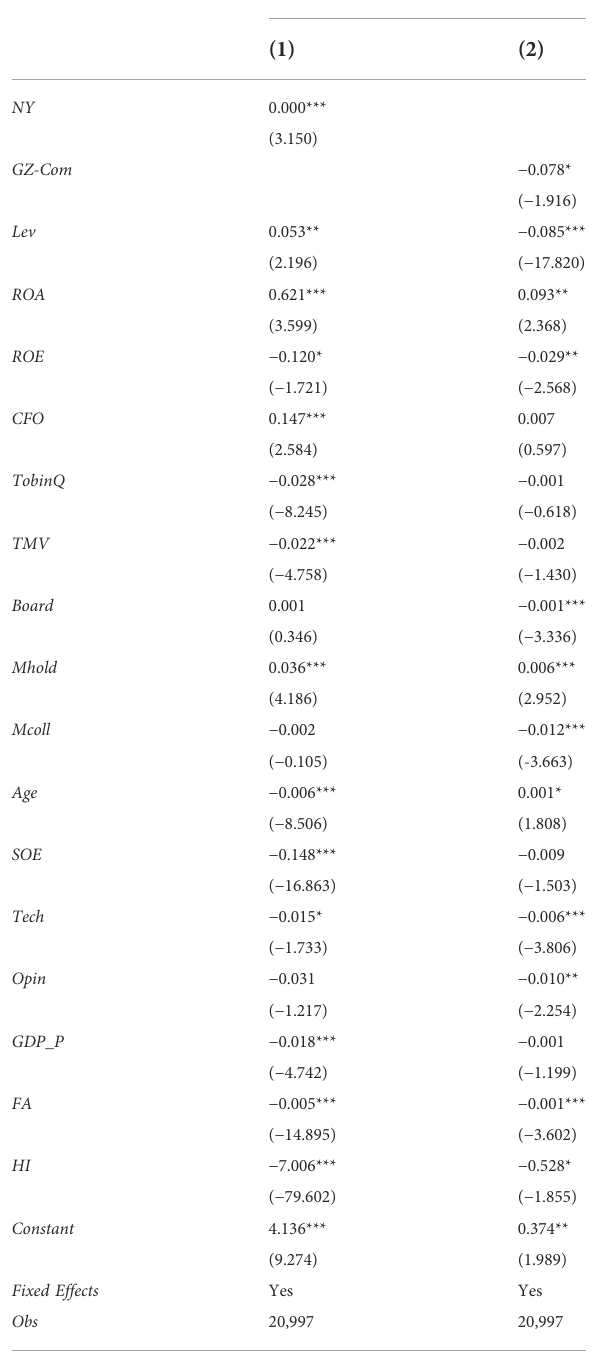
TABLE 4 Endogeneity results of two-stage least squares